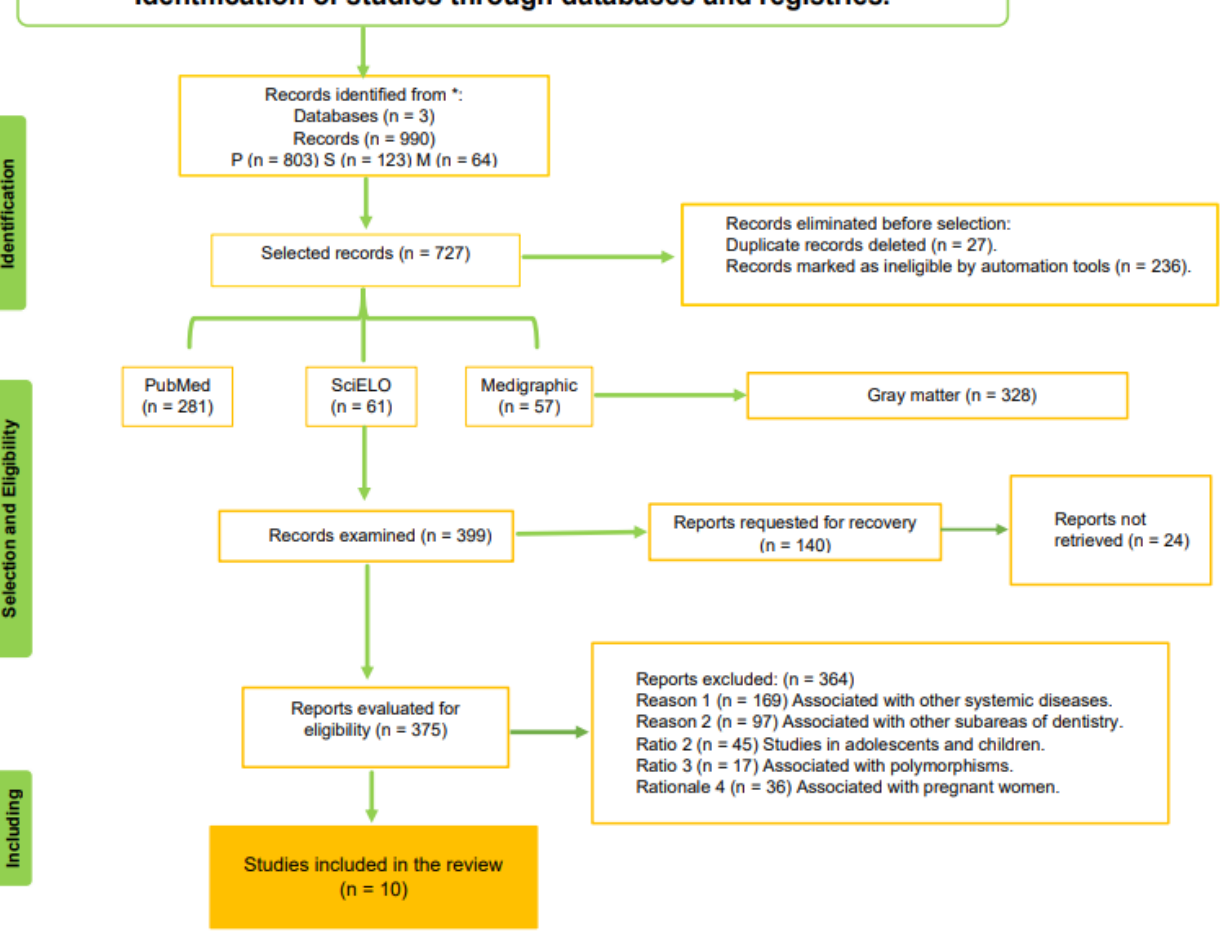
Figure 1. PRISMA flow diagram for the systematic review. Of the 990 articles found in the three databases included in the search, 10 studies were selected for analysis in this study.